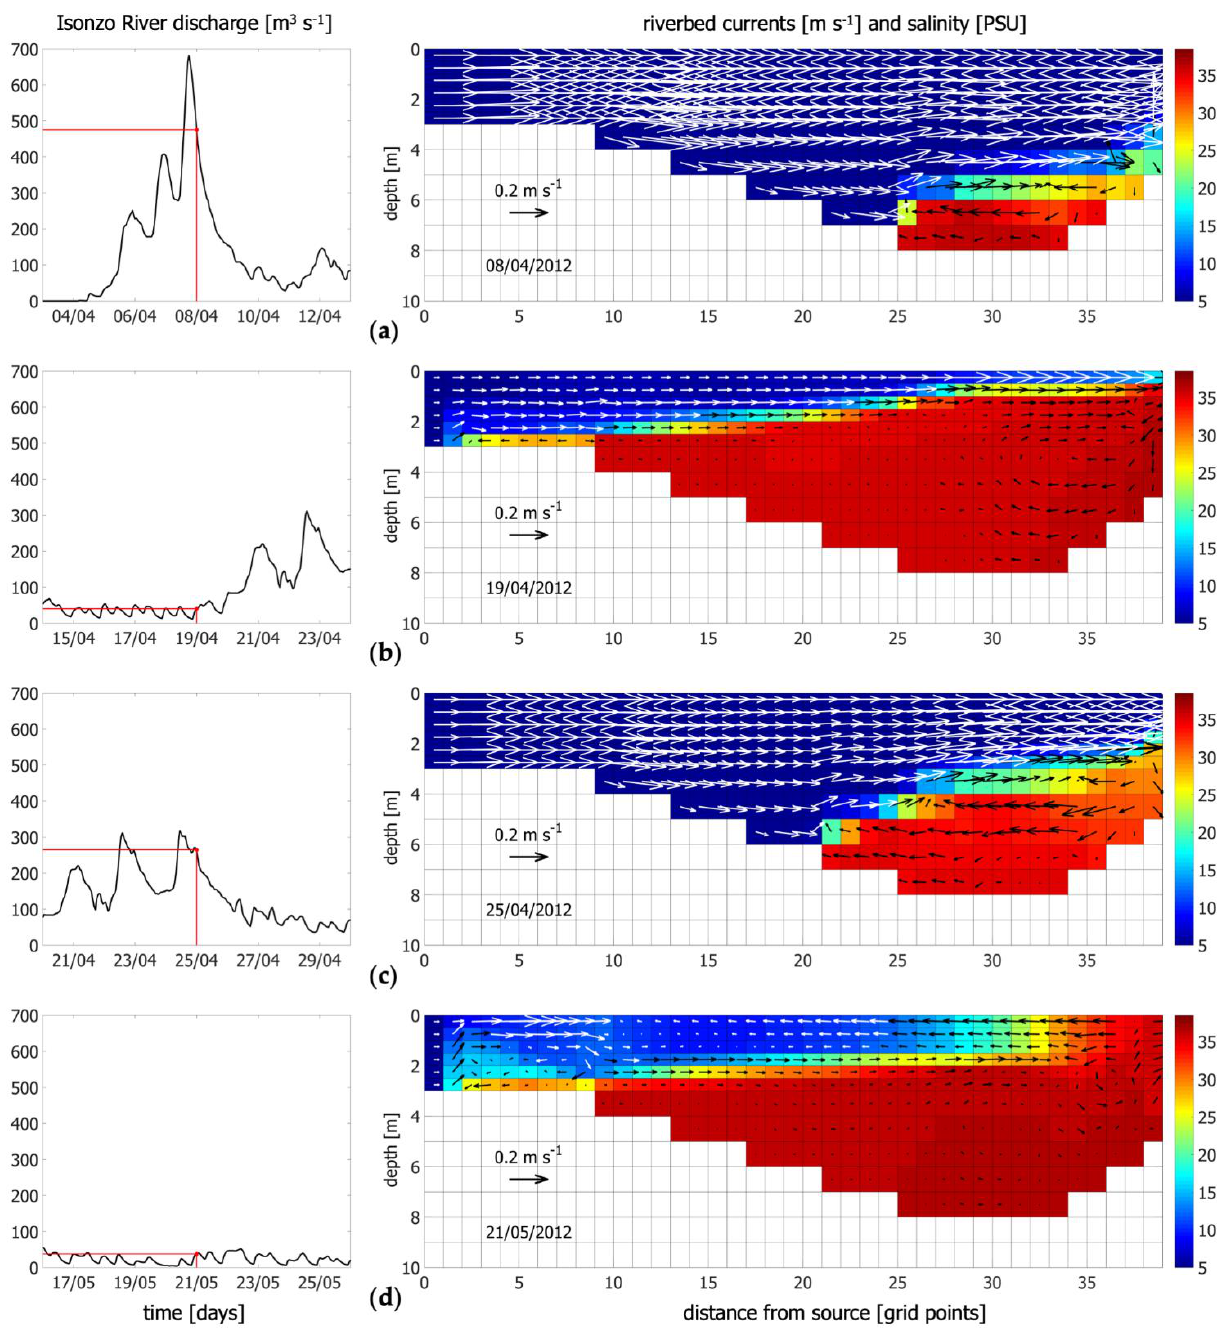
Figure 5. Vertical section of the Isonzo riverbed in different hydrological and meteorological conditions: ( a ) strong flood; ( b ) low discharge; ( c ) average flood; ( d ) low discharge in the presence of strong southerly winds. Left panels show the measured (and imposed to the model) discharge rate. Right panels show the vertical section of salinity and velocity (the simulated river spring and mouth are located on the left and right side, respectively). To improve readability, vectors are colored in white and black, and the vertical component of velocity has been magnified.